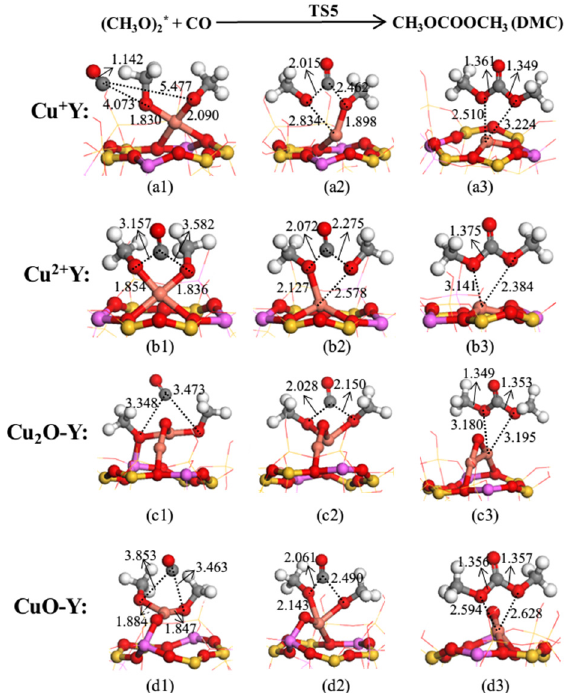
Figure 9. The structures of reactants, products and transition states on Cu + Y, Cu 2+ Y, Cu 2 O-Y and CuO-Y zeolite for the formation of DMC via path II (unit: Å). ( a1 ) (CH 3 O) 2* /CO on Cu + Y, ( a2 ) TS5 on Cu + Y, ( a3 ) DMC on Cu + Y, ( b1 ) (CH 3 O) 2* /CO on Cu 2+ Y, ( b2 ) TS5 on Cu 2+ Y, ( b3 ) DMC on Cu 2+ Y, ( c1 ) (CH 3 O) 2* /CO on Cu 2 O-Y, ( c2 ) TS5 on Cu 2 O-Y, ( c3 ) DMC on Cu 2 O-Y, ( d1 ) (CH 3 O) 2* /CO on CuO-Y, ( d2 ) TS5 on CuO-Y and ( d3 ) DMC on CuO-Y. See Error! Reference source not found. for the color coding.